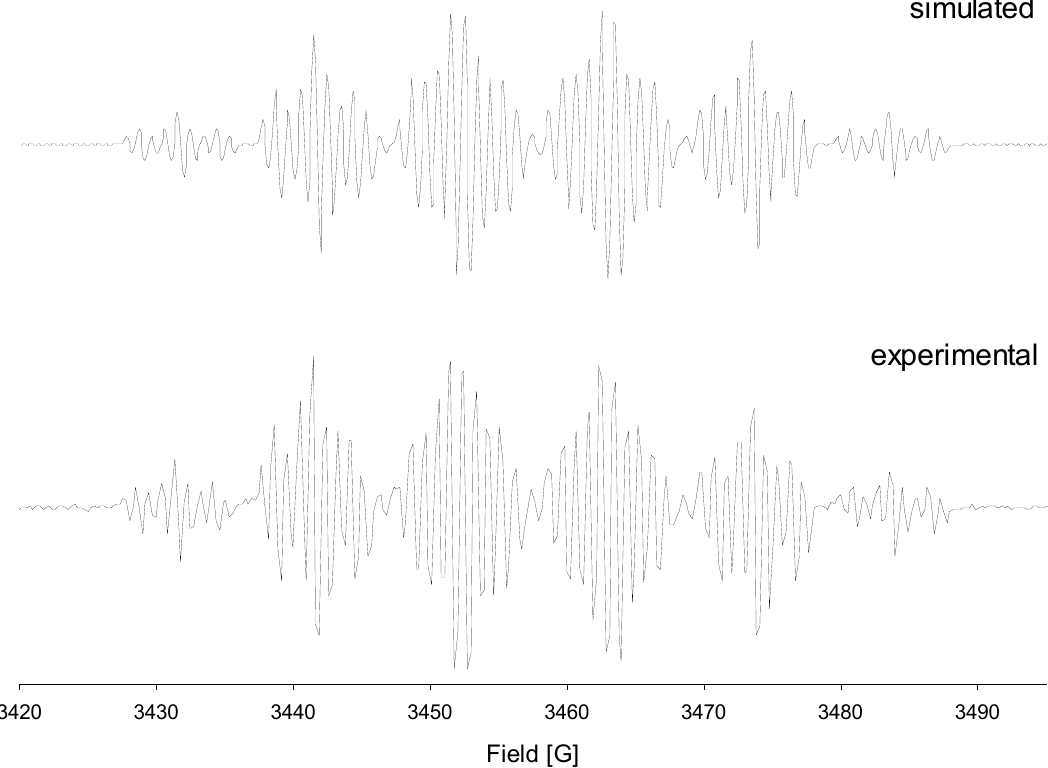
Figure 2. EPR spectrum of the spin trap adduct HO-C 6 H 4 -N(O • )CH 3 , generated in the reaction of complex 2 with p- HO-C 6 H 4 -N=O in the presence of FcOTf in THF. Top: simulated spectrum, bottom: experimental spectrum. Frequency: 9.727 GHz; g-value (vs. DPPH): 2.0044; hyperfine coupling constants: a N : 30.9 MHz, a H,methyl : 27.9 MHz, a H,ortho : 7.9 MHz, a H,meta : 2.6